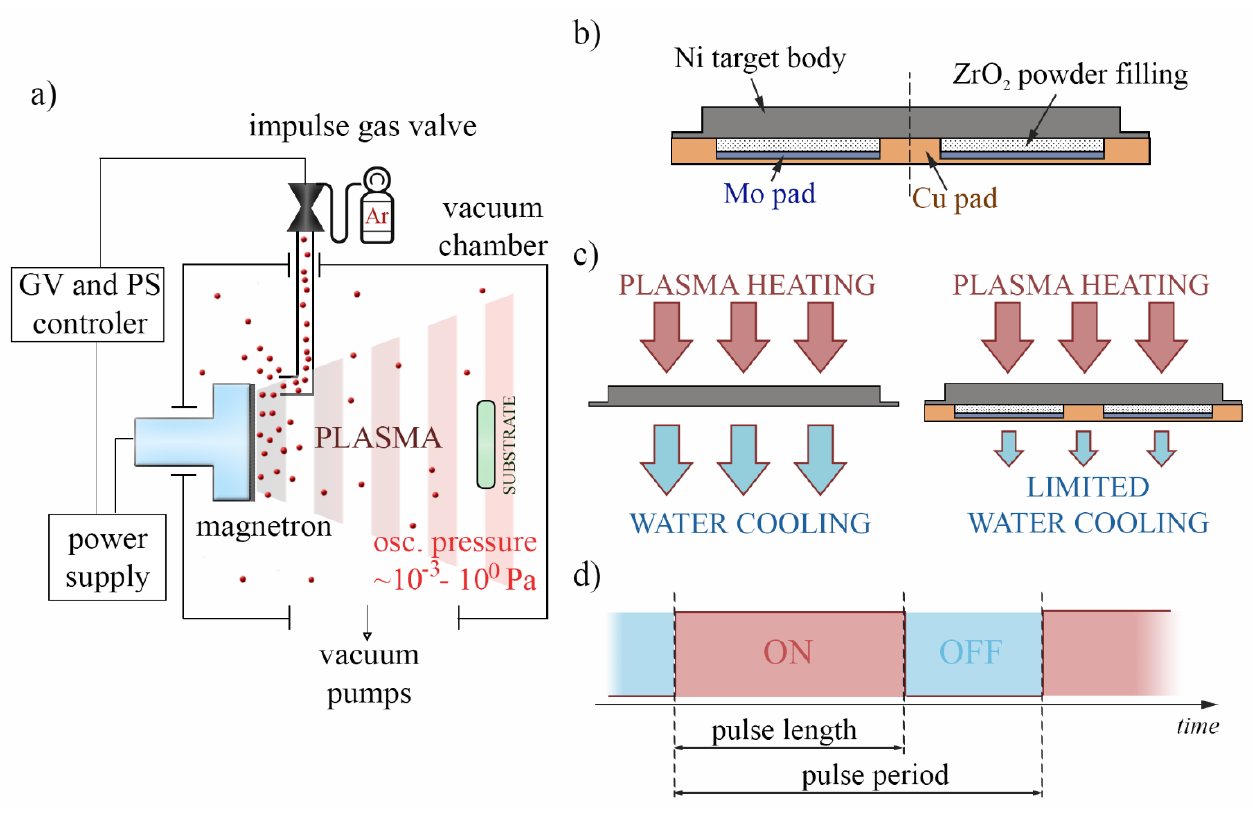
Figure 1. Diagram illustrating: ( a ) the apparatus configuration, ( b ) construction of the hot target system, ( c ) the heat transfer through the standard (left) and hot (right) target system, ( d ) plasma pulse distribution over the time.